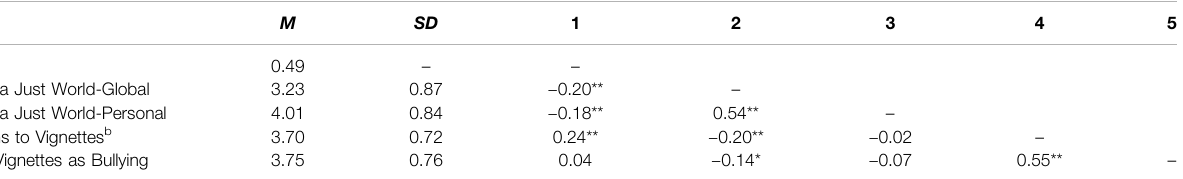
TABLE 1 | Descriptive statistics and Correlations, Study 1 ( n (cid:1)